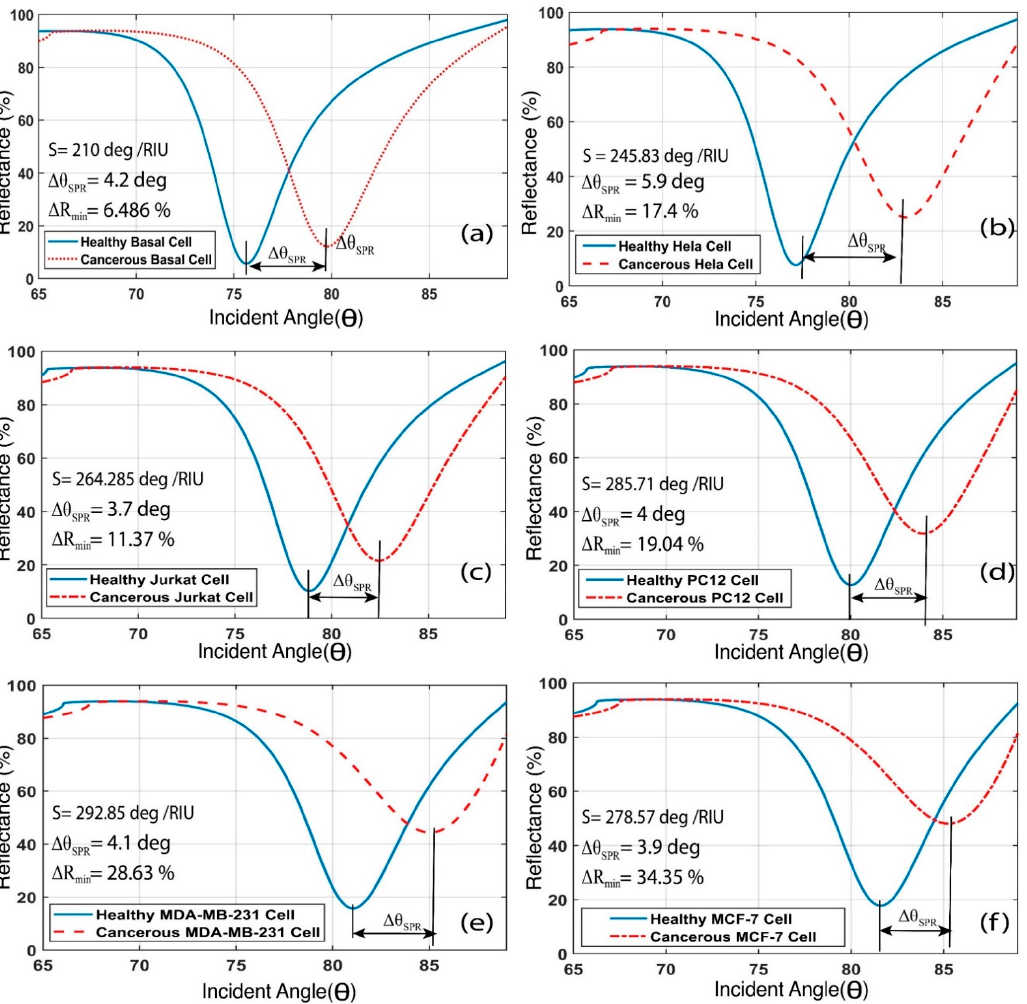
Figure 10. The output reflectance intensity curve with respect to the incident angle and the resonance angle shift due to the refractive index increment for ( a ) basal, ( b ) HeLa, ( c ) Jurkat, ( d ) PC12, ( e ) MDA-MB-231, and ( f ) MCF-7 healthy and cancerous cell analytes. Furthermore, for skin (basal), cervical (HeLa), adrenal gland (PC12), blood (Jurkat), Table 6. Sensitivity analysis of the proposed biosensor for healthy and cancerous cell analyte and breast (MCF-7 and MDA-MB-231) normal and cancerous cells, the resonance and SPR angle shifts are 4.2 deg, 5.9 deg, 3.7 deg, 4 deg, 4.1 deg, and 3.9 deg, respectively. There- fore, the resonance angle angular shift sensitivity of the skin (basal), cervical (HeLa), ad-